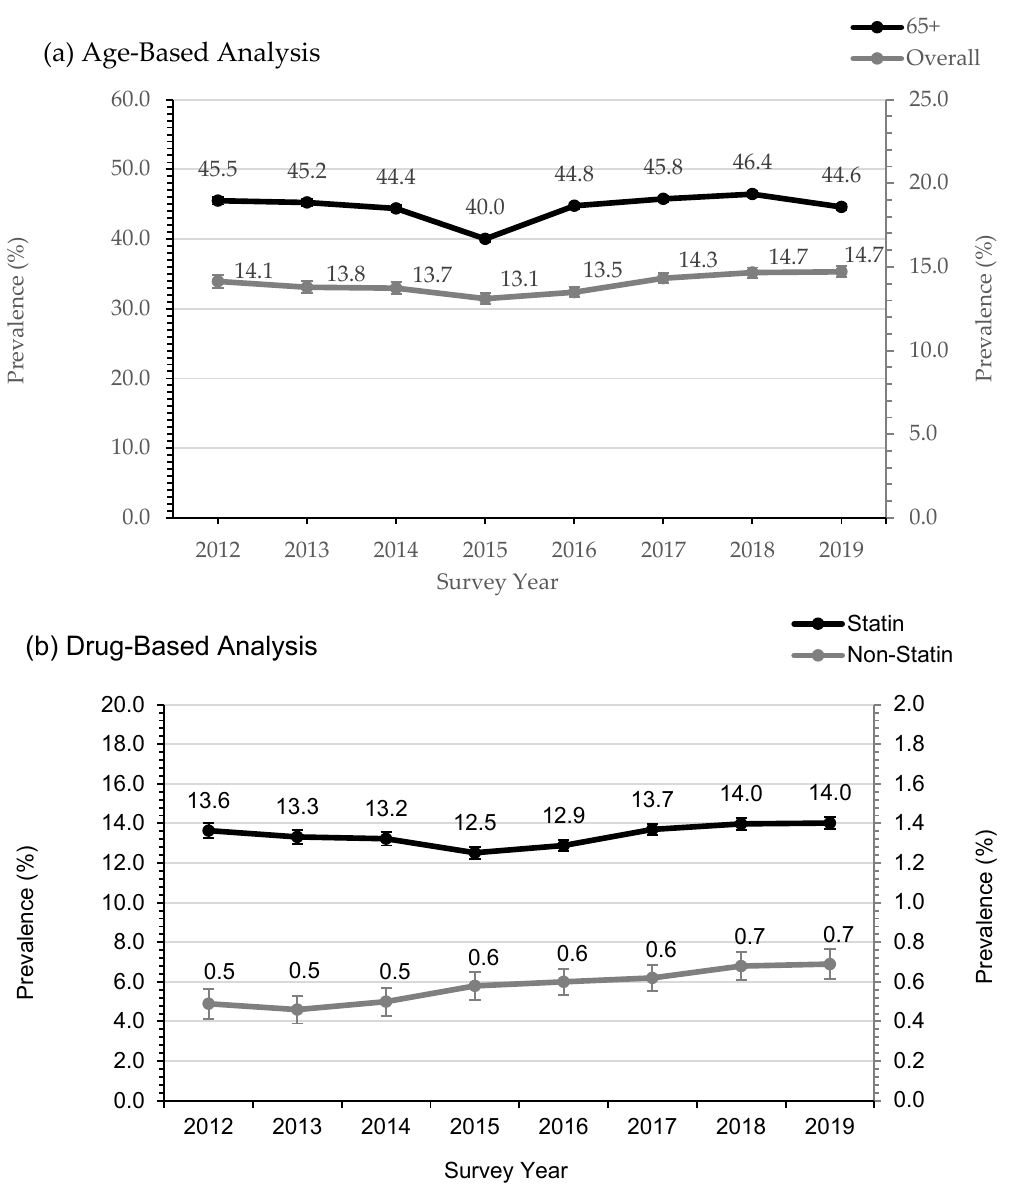
Figure 2. Prevalence of lipid-lowering medications in the ePBRN .